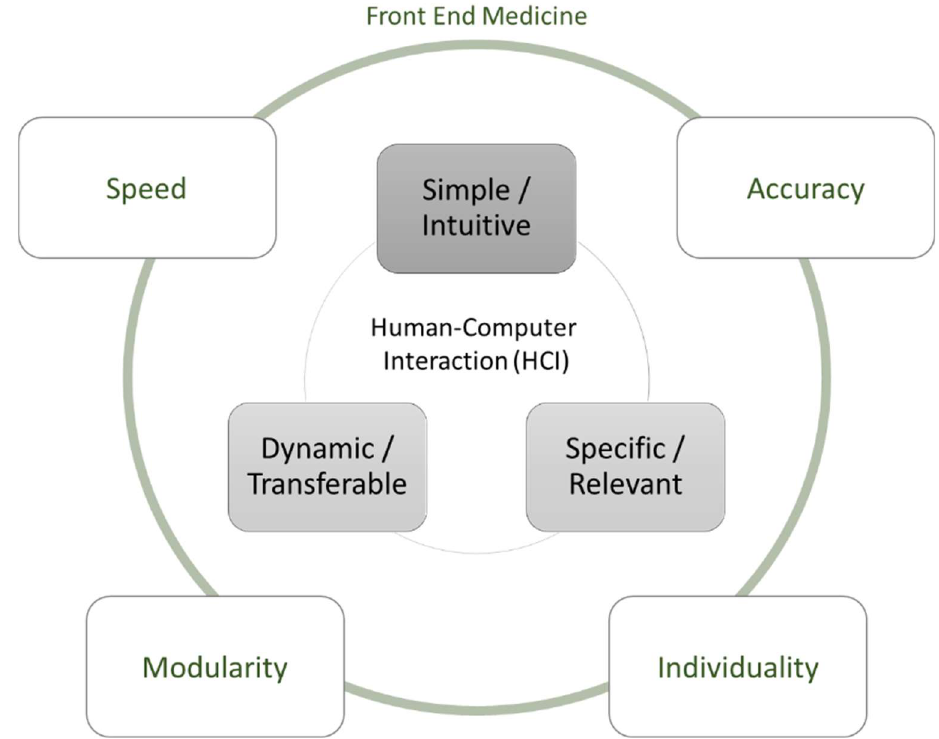
Figure 7. Concept draft of the front end of medicine HCI requirements.